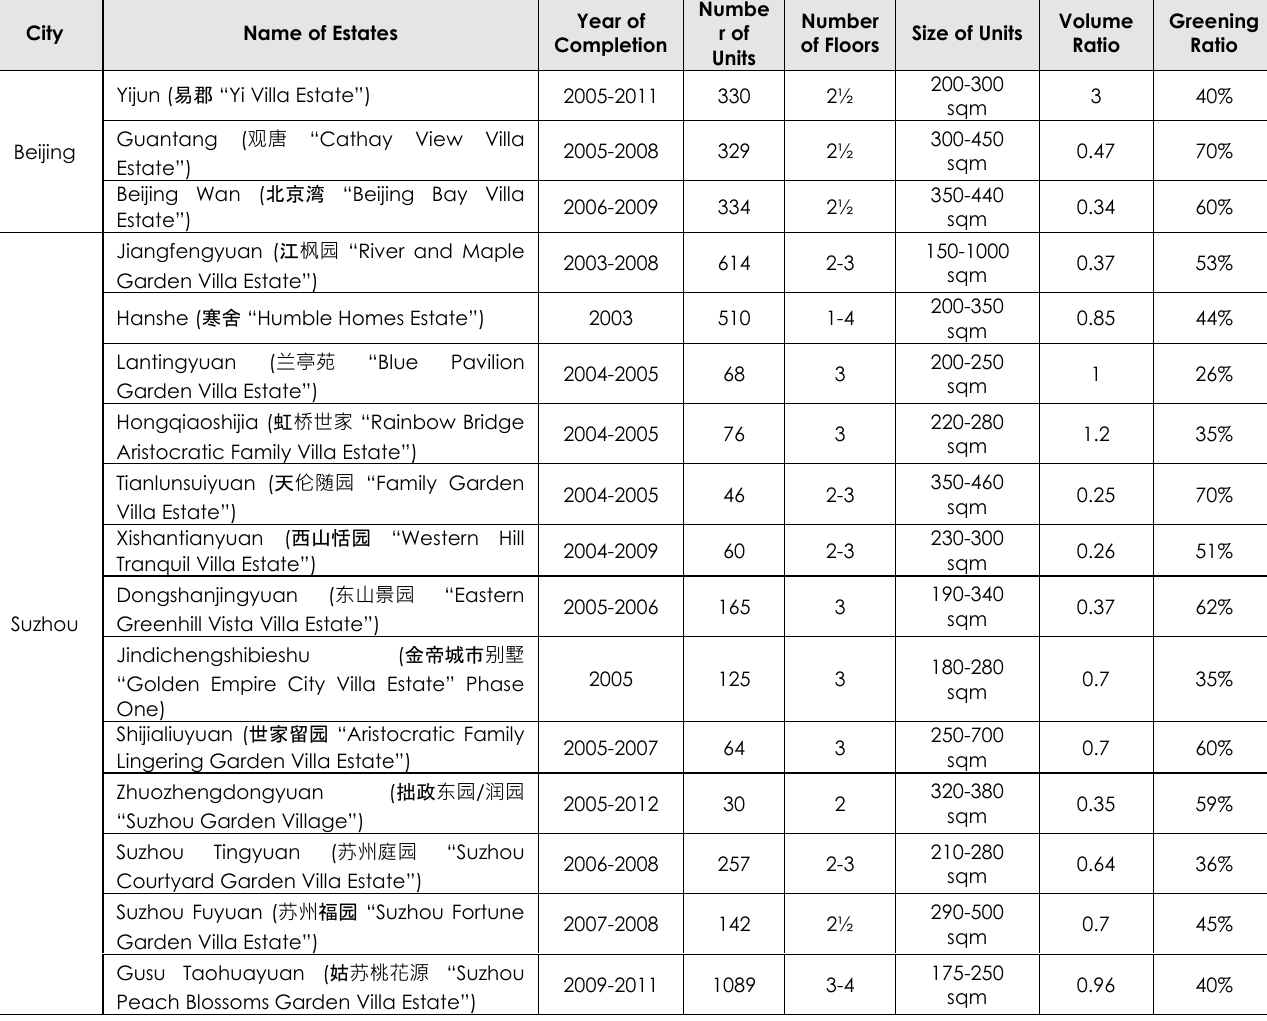
Table 3. Second-generation Chinese-style courtyard garden villa estates constructed in China since the